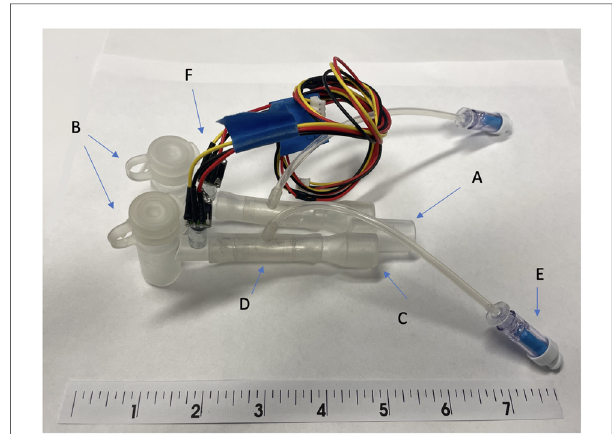
FIGURE 2 The early prototype of system for asymmetric fl ow regulation (SAFR). ( A ) Proximal end terminates at the connection with the mechanical ventilator circuit ( B ) Body of the SAFR branches into two channels, each containing the Flow Regulating Inner Balloon ( C ) Two distal ends connect to the double lumen tubes ’ proximal (outside) outlets ( D ) Flow Regulator Inner Balloon control valve inside each of the two SAFR limbs. A Flow has capacity to occlude both lumens completely allowing for static pressures assessment and change the lumen effective diameter and surface area in each of the lumens which allows for control over uneven distribution of gas fl ow coming from the ventilator. ( E ) Flow Regulator in fl ation valve connects to the Flow Regulation external pneumatic system which controls precise Inner Balloon in fl ation and de fl ation during the respiratory cycle. ( F ) Pressure sensors and/or end-tidal CO 2 micro-sensors are embedded into the walls of each lumen distally and connected to the outer Monitor via wires embedded in the tube connecting distal sensors to proximally externalized Monito.